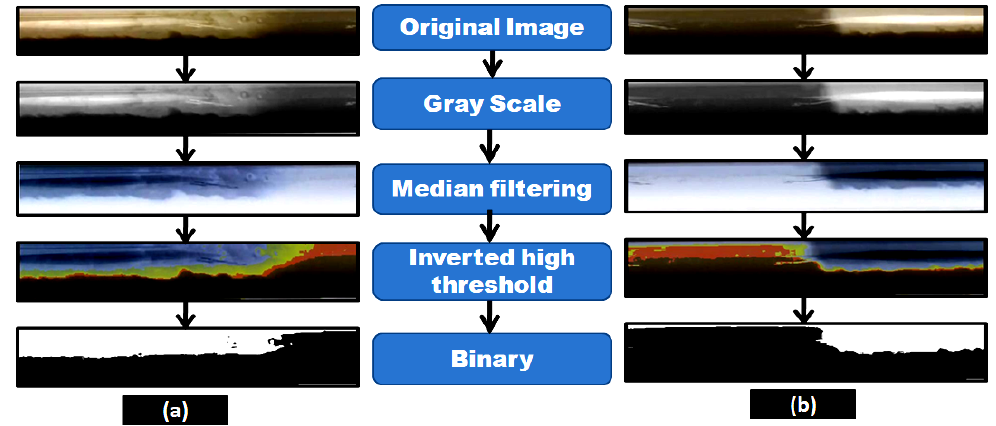
Figure 5. Images of slug flow: ( a ) bubble nose and ( b ) bubble tail.